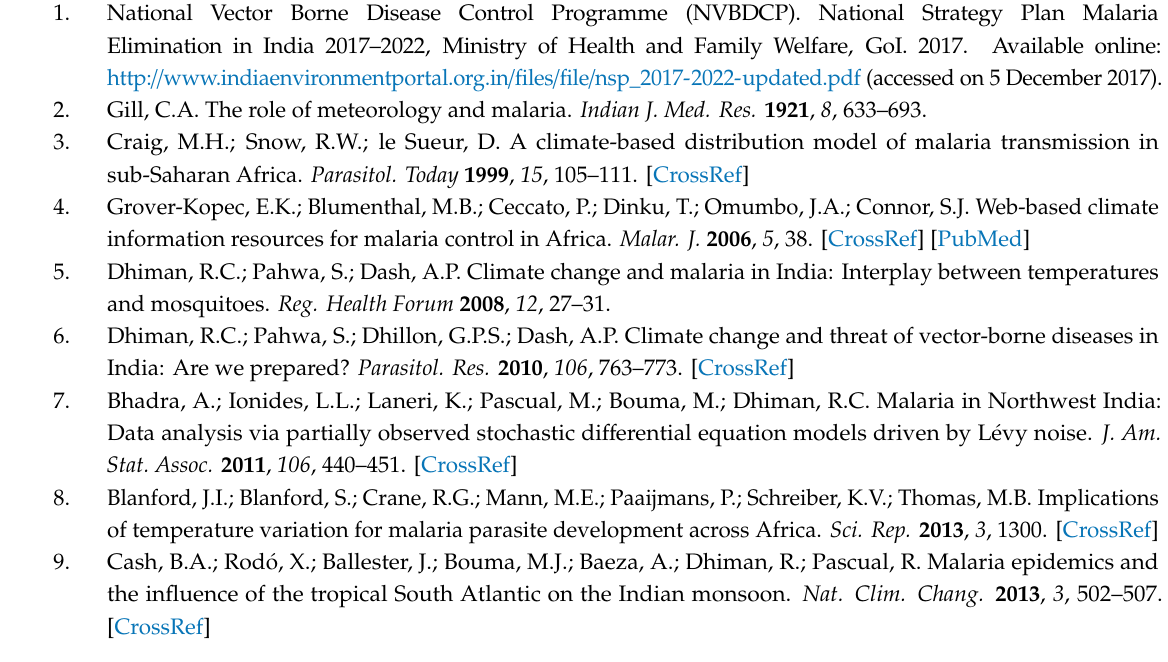
Figure S1: Temperature and RH suitability for baseline years and projected 2030s, Figure S2. Map showing the potential districts as new foci for Pv malaria